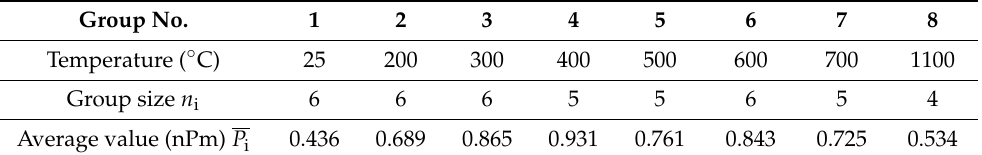
Table A2. Average value of each group data of air permeability. Group